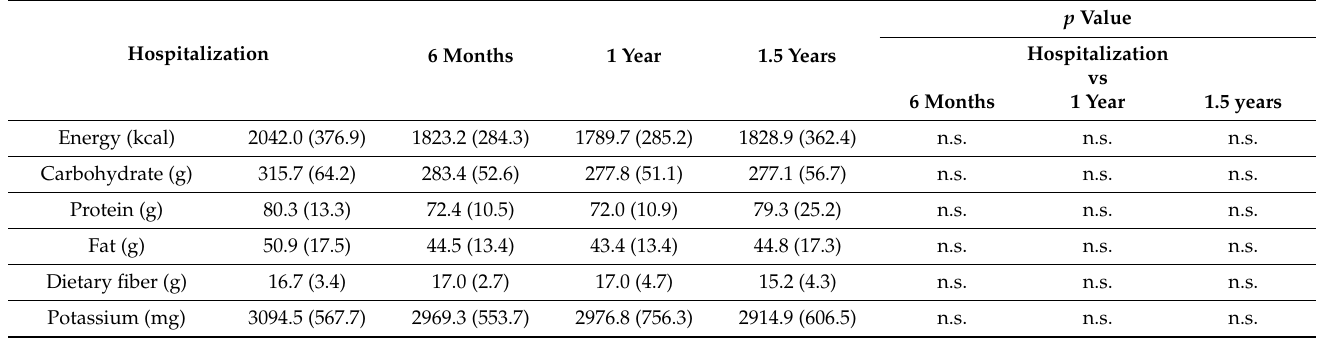
Table 4. Changes in the nutrient intake ( n = 15).